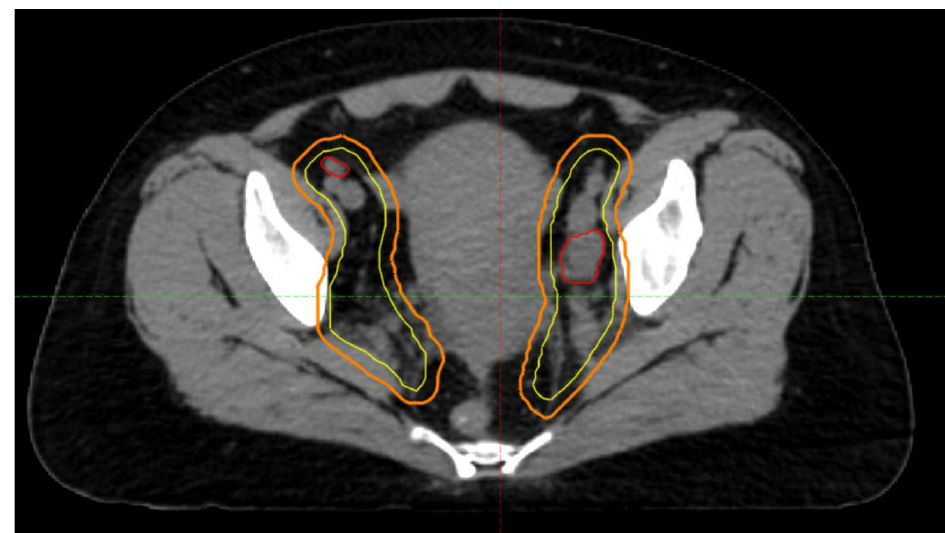
Figure 2. Representation of GTV, CTV, and PTV. A gross lymph node represents the GTV in red. The pelvic lymph node basin is the CTV in yellow with a 5 mm expansion to create the PTV in orange. Treatment planning is particularly challenging for GYN cancers for several reasons.